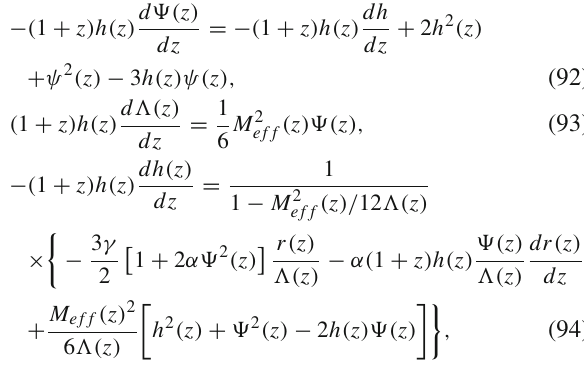
Fig. 3 Variation as a function of the redshift of the Weyl vector com- ponent (cid:18)( z ) for the geometry-matter coupling function F α ˜ Q + β ˜ T for α = − 1 . 95, M = 0 . 95, and for different values of β : β = − 2 . 64 (solid curve), β = − 2 . 78 (dotted curve), β = − 2 . 91 (short dashed curve), β = − 3 . 07 (dashed curve), and β = − 3 . 24 (long dashed curve). To integrate the system of cosmological evolution equa- tions we have used the initial conditions h ( 0 ) = 1, (cid:18)( 0 ) = 0 . 555, and (cid:4)( 0 ) = 0 . 568